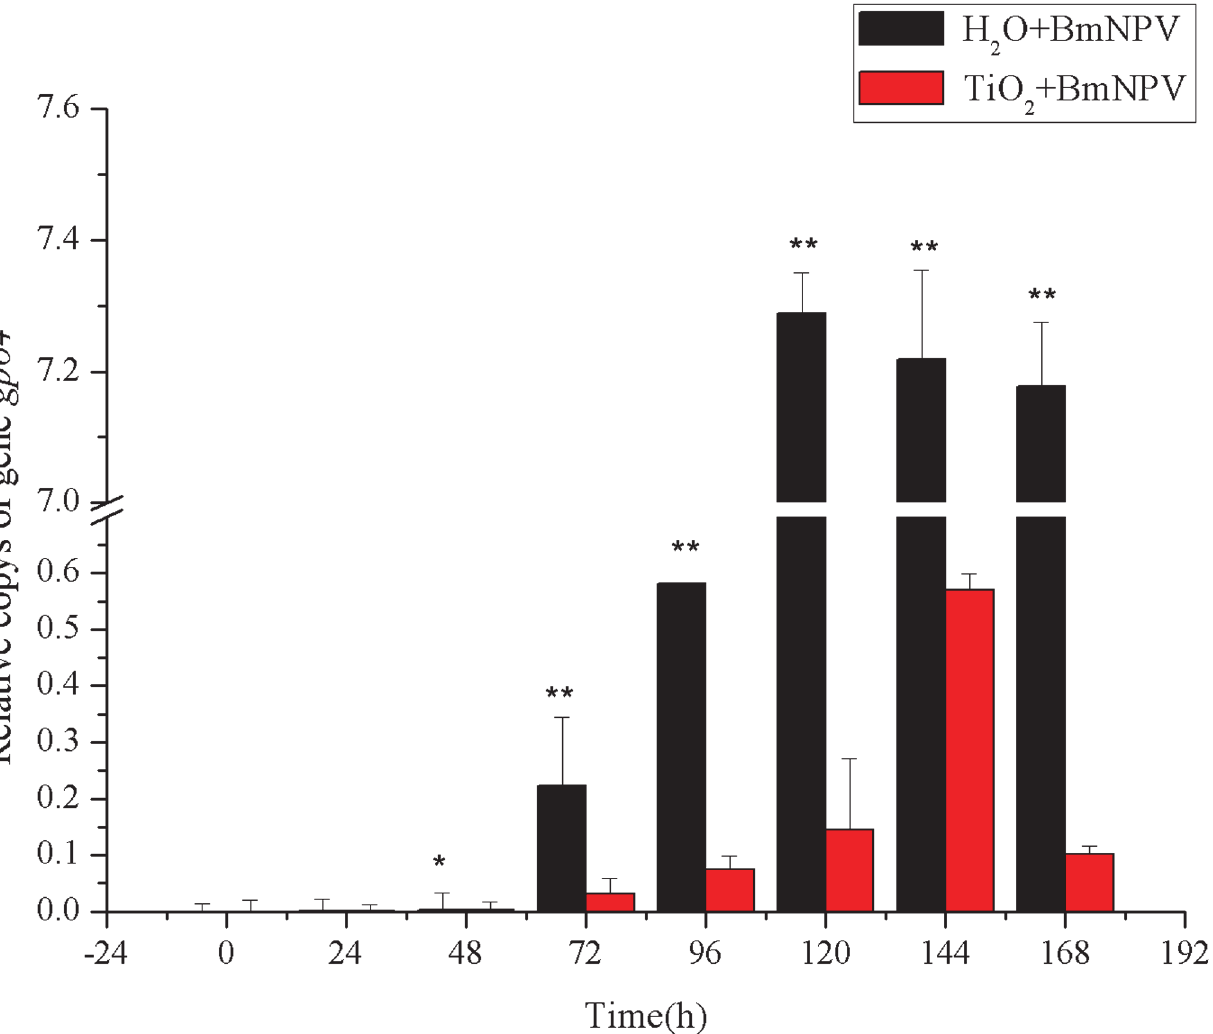
Fig 5. Relative copies of gp64 . Black and red histograms represent the control group and the experimental group, respectively. X and Y axes represent the time after infection and the relative copy numbers BmNPV gp64 , respectively. The bars in the figure with different letters indicate statistically significant differences ( p <